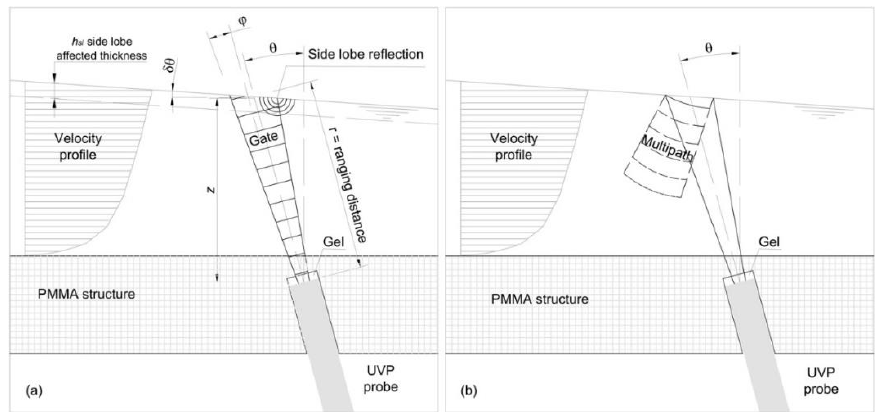
Figure 2. ( a ) Outline of UVP probe deploy at the dike crest with the acoustic beam geometry, the range gating and side lobe reflection. ϕ is the half beam width, z is the probe tip to water surface vertical distance, and θ and δθ indicate the beam angle with respect to vertical and the water surface slope, respectively. ( b ) Outline of the multipath following the reflection at the free surface.